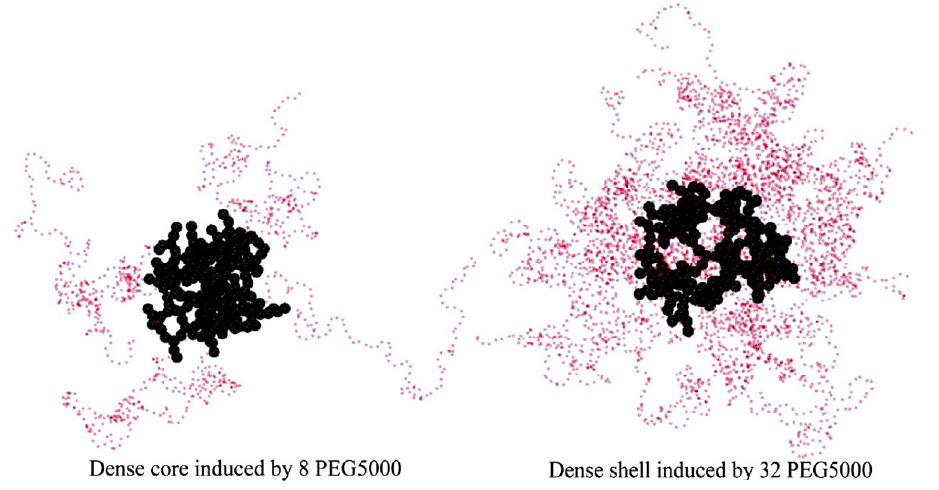
Figure 5. Snapshots of G4 dendrimers attached with 8 PEG5000 (left) and 32 PEG5000 (right) at the end of simulations, leading to dense-core and dense-shell structures, respectively. Black and red colors represent dendrimers and PEG chains,